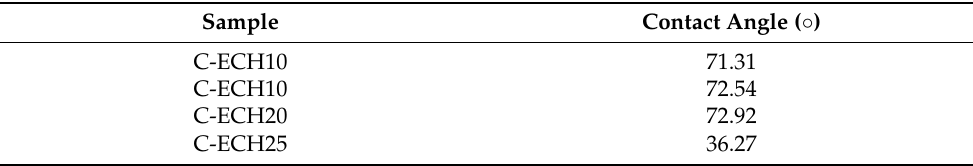
Table 1. Water contact angle of cellulose bioplastic.